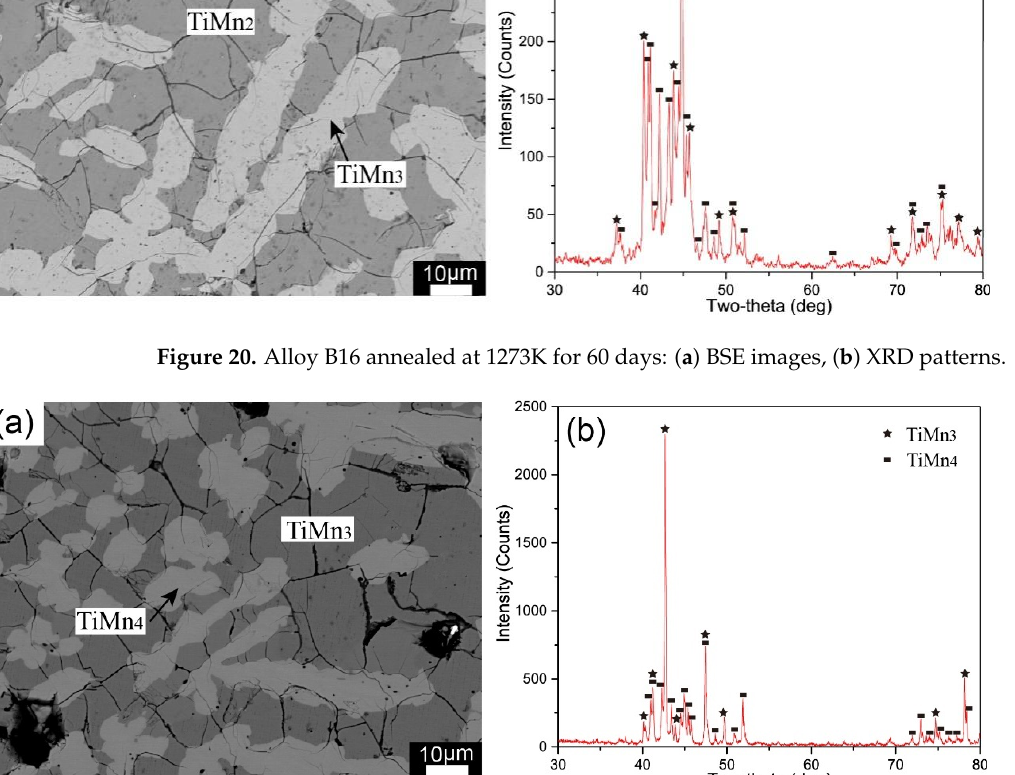
Figure 21. Alloy B19 annealed at 1273K for 60 days: ( a ) BSE images, ( b ) XRD patterns.